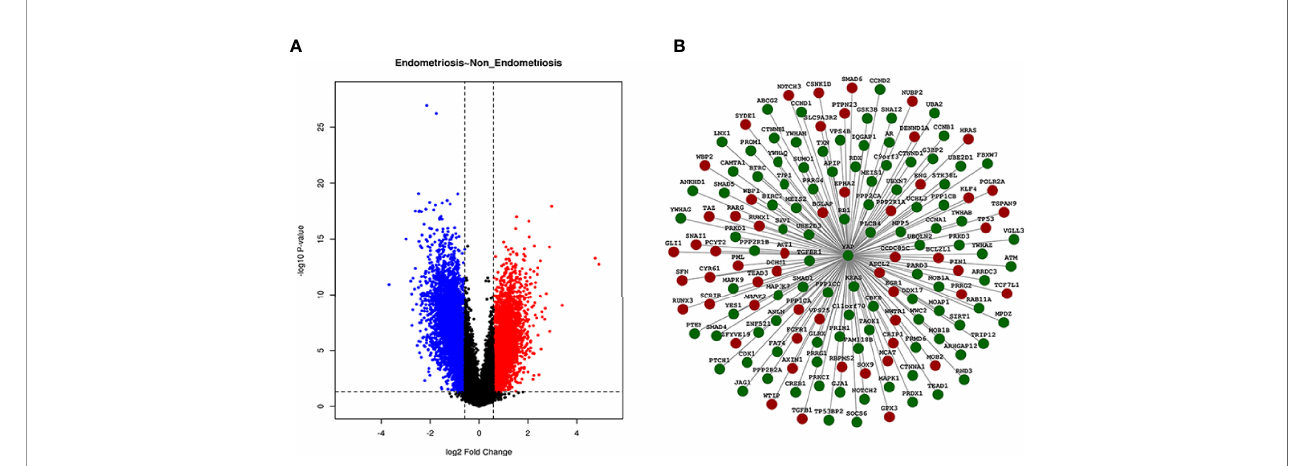
FIGURE 1 | Volcano Plot and PPI network of DEGs. In the Volcano Plot, genes that are upregulated are in red, those that are downregulated are in blue, and those that are insigni fi cantly different are in black (A) . Different protein interaction graph with YAP interaction scores greater than 0.4 in GSE51981 samples were shown in the PPI network. Green indicates downregulated expression and red indicates upregulated expression (B)